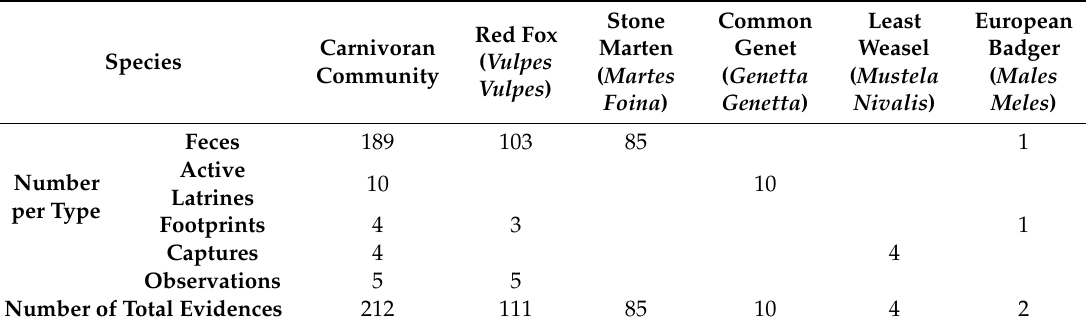
Table 1. Number of carnivoran evidences per